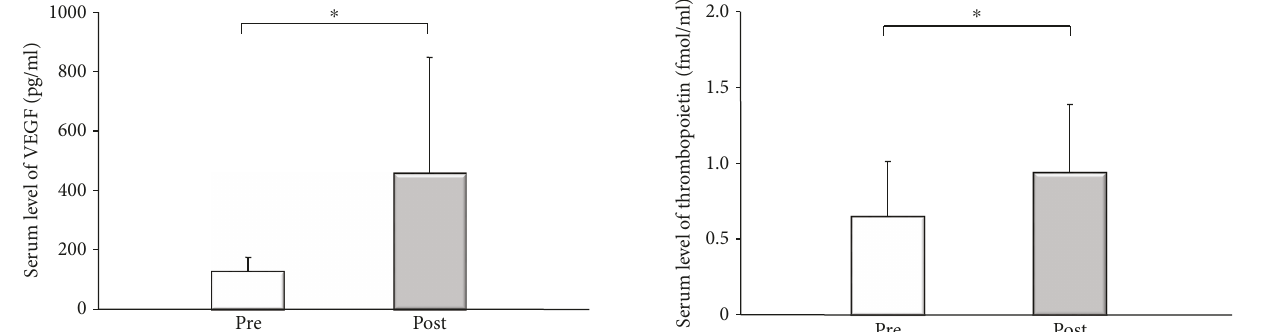
Figure 5: Serum level of thrombopoietin (TPO) before and 4 weeks after partial splenic embolization (PSE). TPO increased after PSE (from 0.69 ± 0.3 to 0.86 ± 0.5fmol/min: ∗ p = 0 0464 , by Wilcoxon ’ s